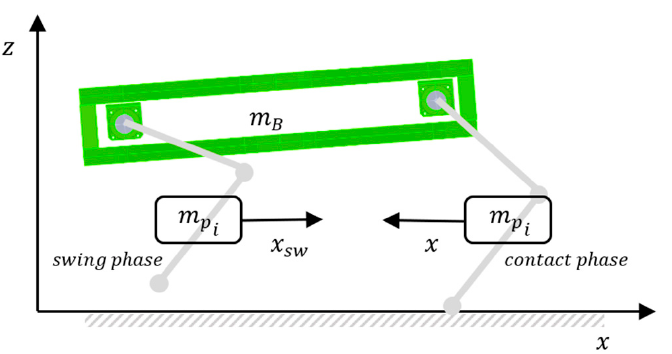
Figure 5. Illustration of the reciprocating longitudinal leg motion during the swing and contact phases, respectively.